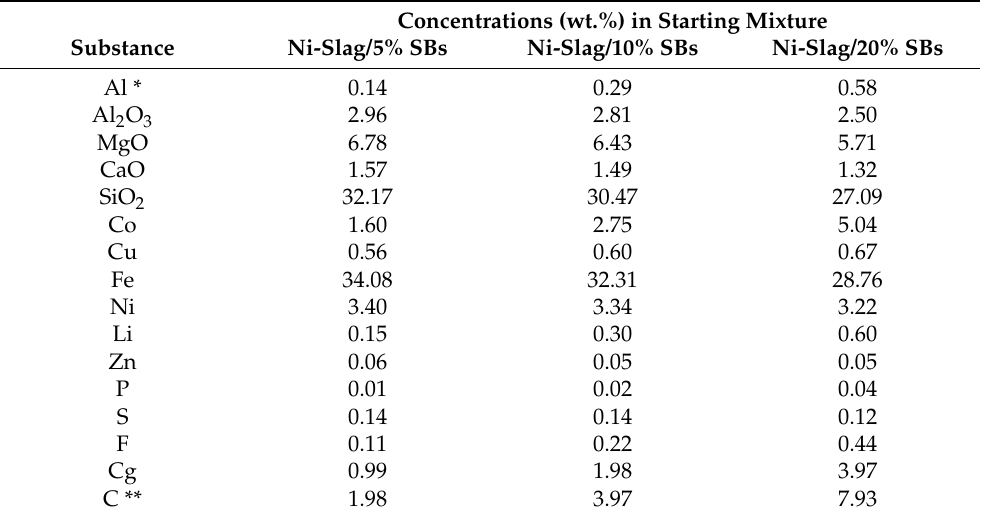
Table 6. Chemical composition of the starting mixtures with 5, 10, and 20 wt.% of spent batteries (SBs).